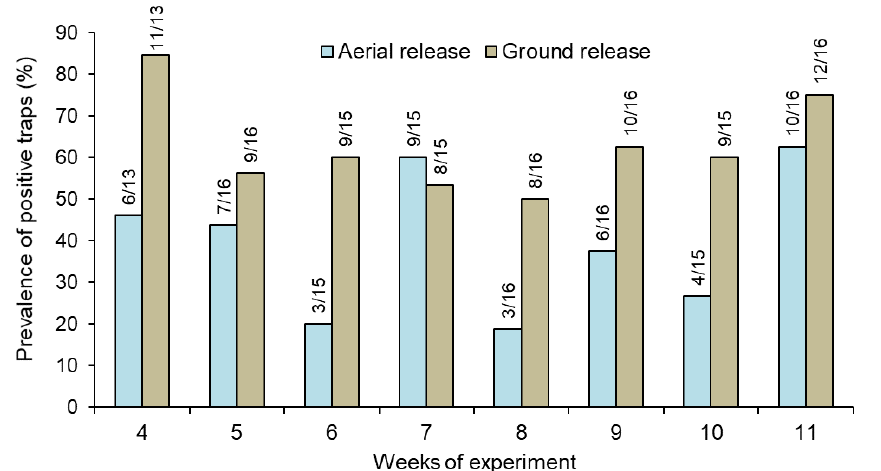
Figure 2. Prevalence (%) of traps that captured at least one sterile male Aedes aegypti released through ground and aerial in houses in Hidalgo village. Numbers above columns indicate the number of positive traps out of the total number of traps sampled each week (see Table 1 for the weekly number of traps sampled).